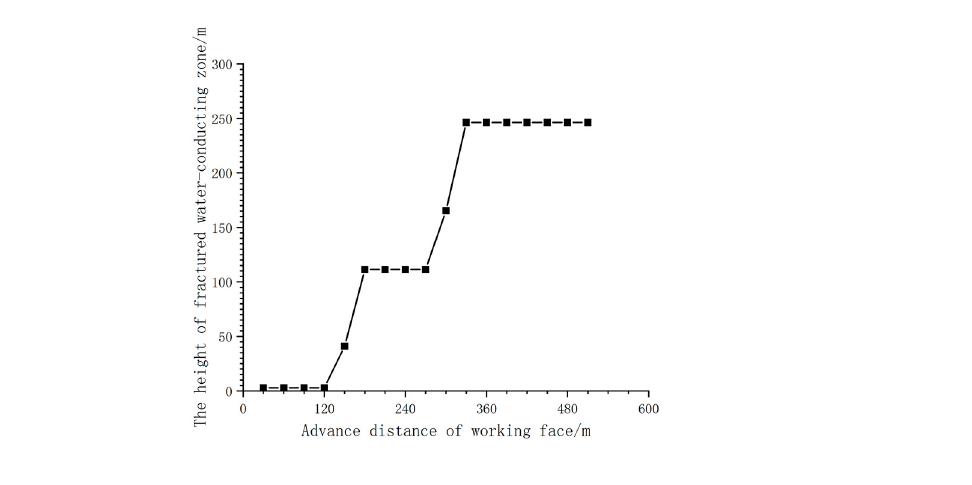
Figure 11. Statistics of the height of the water-conducting fracture zone with the physical analog model.